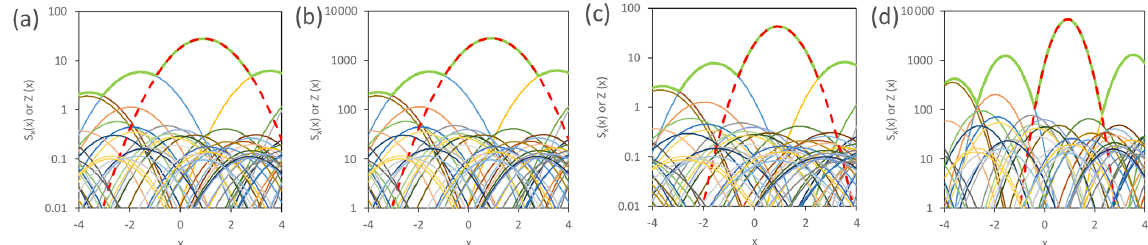
Figure 1. Examples of simulated fields of local event intensities and enveloping field of maxima (bold green line) generated with standard normal PDF as Y( x ) in (6, 7, 9, 10) and the same series of numbers from pseudo-random generator: (a) max-stable and n = 1, (b) max-stable and n = 100, (c) non-max-stable and n = 1, and (d) non-max-stable and n = 100. The strongest event has a broken red line.